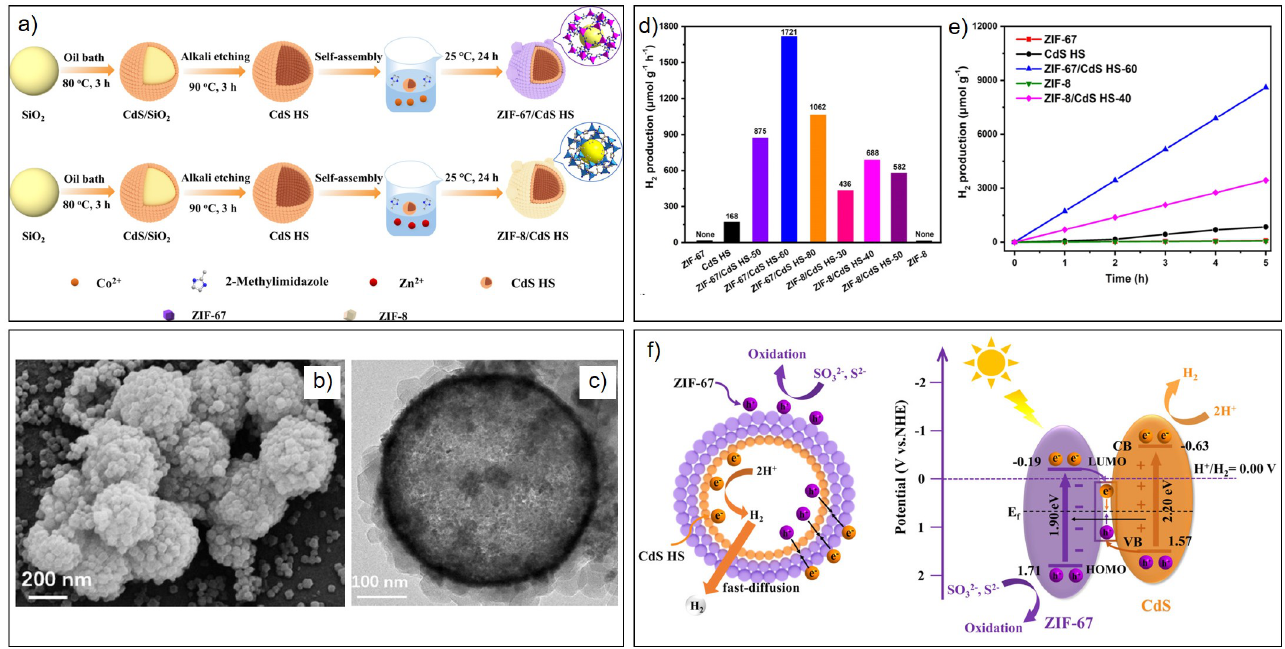
Figure 14. ( a ) The synthesis procedure of the ZIF-67/CdS HS and ZIF-8/CdS HS. ( b ) TEM and ( c ) SEM images of the ZIF-8/CdS HS heterostructures. CdS HSs are rapped with the ZIF-8 to form “double-shell” like structure, indicating close contact between the two components. ( d ) Hydrogen evolution rates and ( e ) time-dependent photocatalytic performances of various catalysts. ( f ) Schematic view of the charge transfer mechanism over the ZIF-67/CdS HS photocatalyst under Vis-light illumination [130]. Copyright 2022, American Chemical